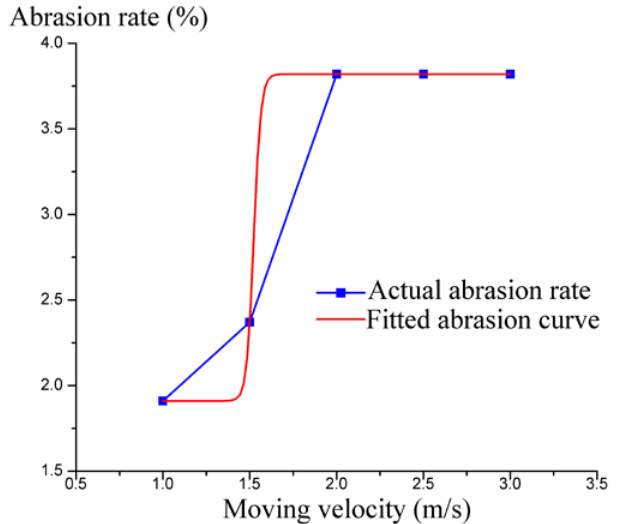
Figure 7: Variation of moving velocity on the abrasion property of hydraulic hammer with horizontal oriented sliders. The actual simulation results are slightly different with the fitted abrasion rates. The maximum deviation between simulation results and the logarithmically fitted abrasion rate is less than 2%, which is tolerable in real time operation of hydraulic hammers with horizontal oriented sliders. Meanwhile, the abrasion rate of horizontal oriented sliders is